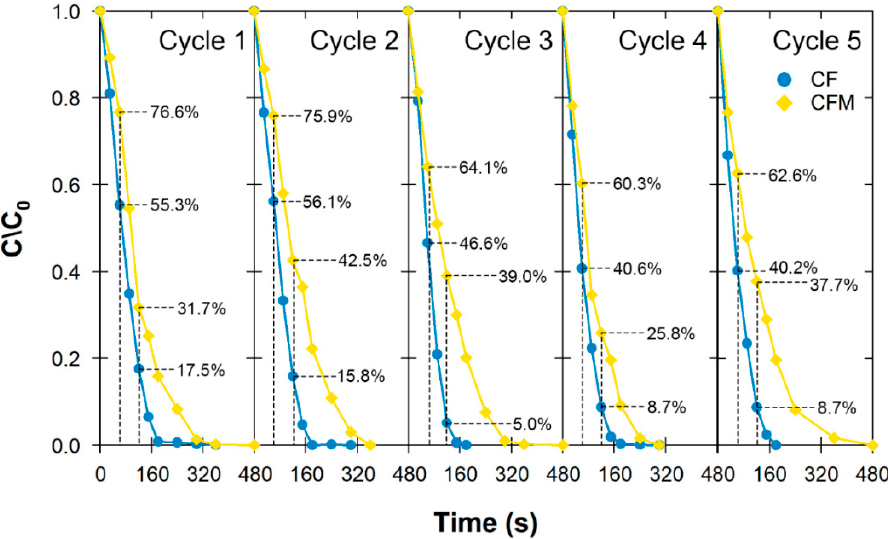
Figure 7. Degradation of BP following five cycles of pumping BP-contaminated water through the catalytic ozonation system using CF or CFM (each catalyst: 0.2 g L − 1 , [BP o ]: 10 µM, pH 7, 25 °C).